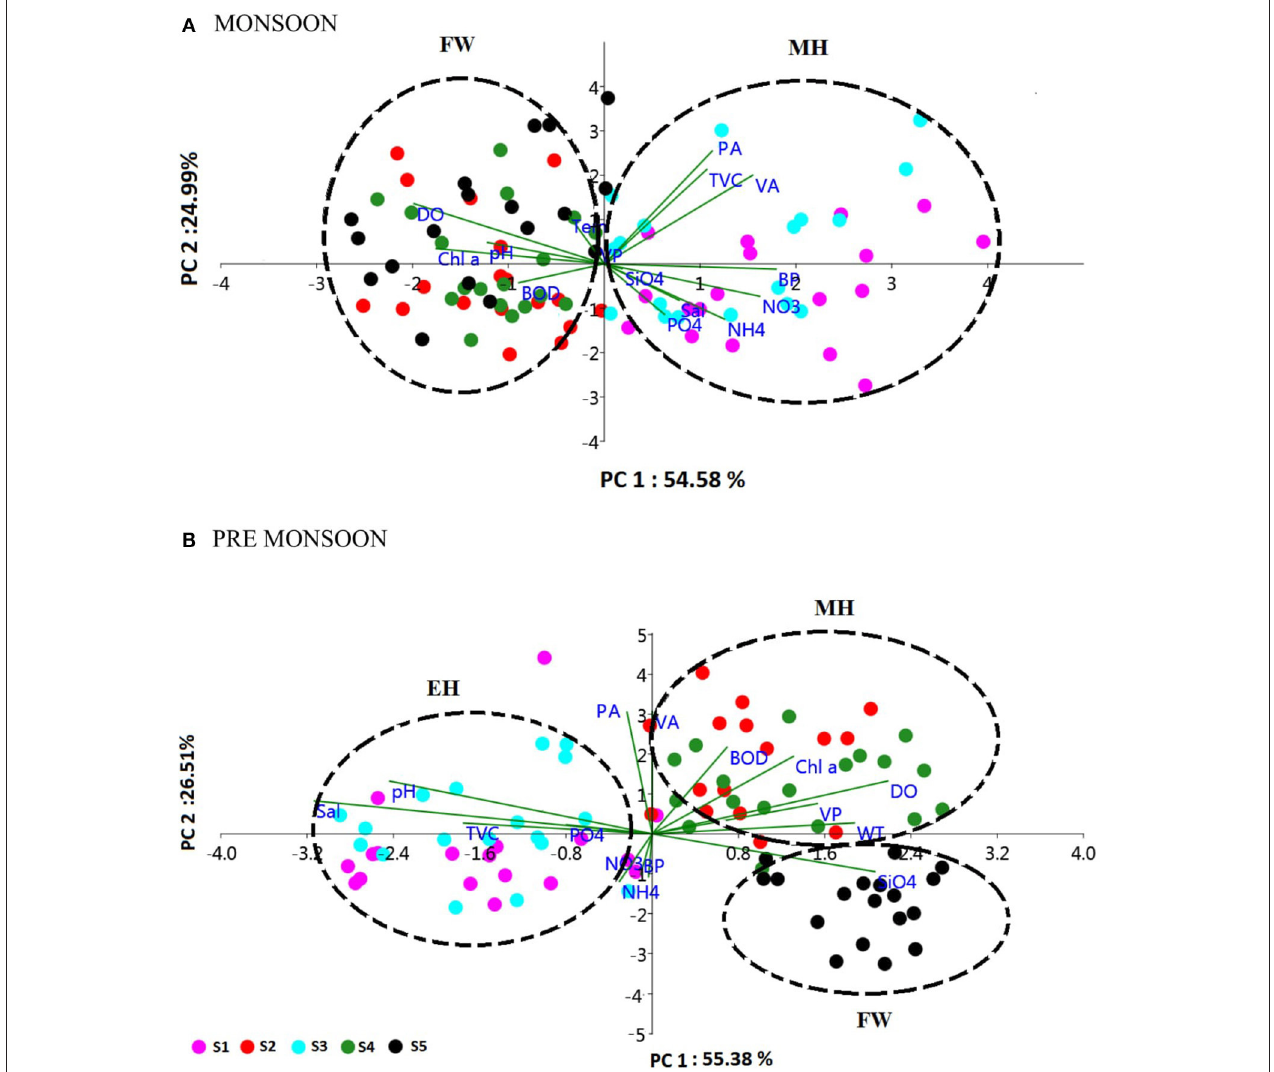
FIGURE 6 | Principal component analysis (PCA) biplot representing the distribution of biological parameters and interrelationships of physico-chemical and biological parameters during (A) monsoon (MON) and (B) pre-monsoon (PRM). The sampling stations (S1–S5) are represented as different color spots. The % variance explained by PC1 and PC2 is 54.58 and 24.99% in MON and 55.38 and 26.51% in PRM, respectively. The clusters are named as euryhaline (EH), mesohaline (MH) and freshwater (FW), based on the salinity